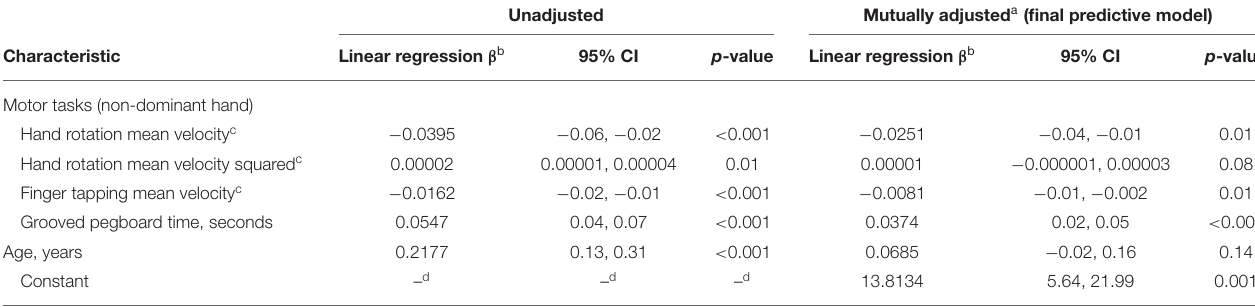
TABLE 2 | UPDRS3 predictive model in the training dataset ( N = 275), South Africa, 2016–2020.